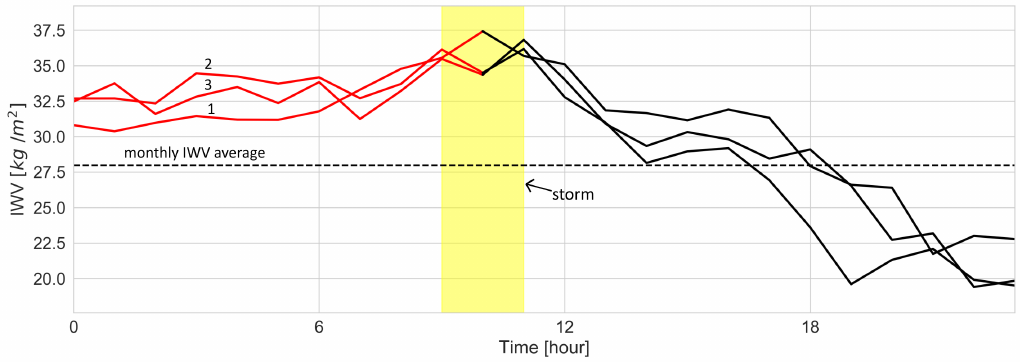
Figure 3. Time series of IWV values for 3 analyzed points (blue line) and storm occurrence (yellow bars) for 12 August 2017. The monthly IWV(ST) threshold is indicated as a dashed black line. The line numbering refers to the locations presented on the map in Figure 2.